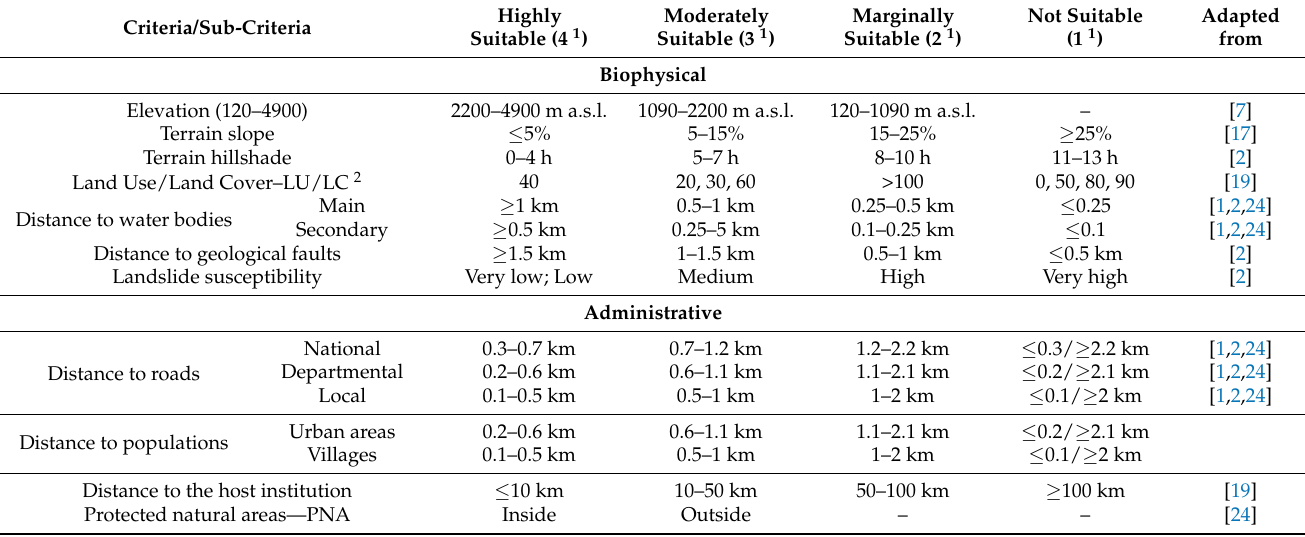
Table 1. Sub criteria scoring for selecting weather station sites in Amazonas, NW